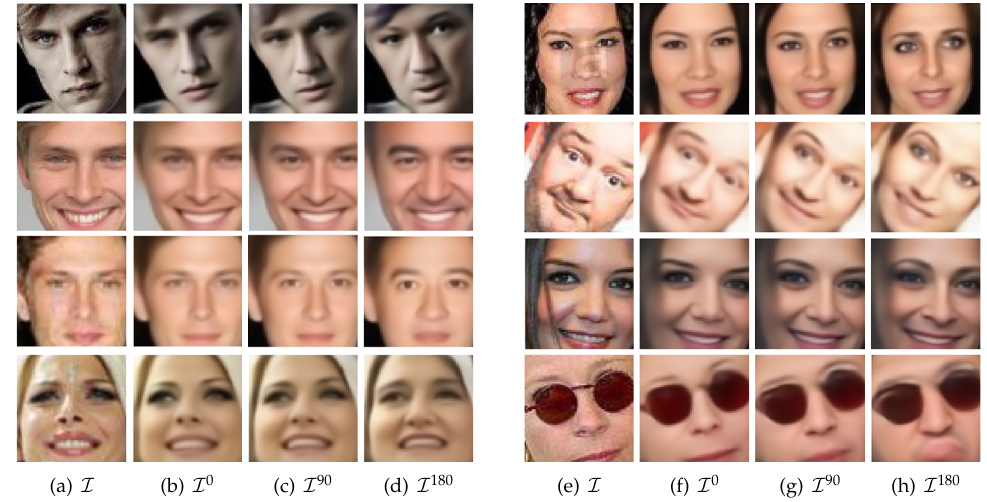
Figure 6. Results from the VGGFace2 dataset. ( a , e ) show original input images, ( b,f ) show reconstructed images (i.e. rotated with 0 degrees), ( c,g ) show de-identified faces by rotating 90 degrees, and ( d,h ) show de-identified faces by rotating 180